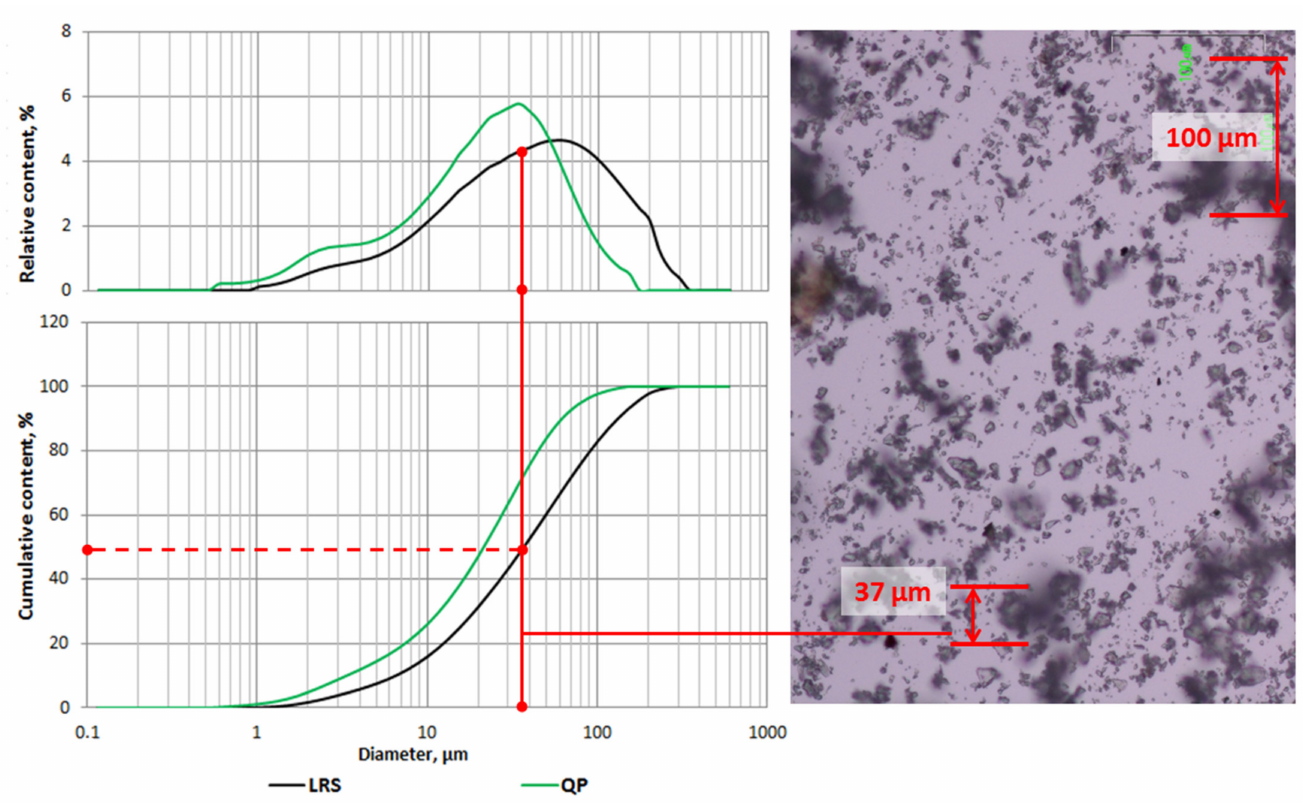
Figure 4. Particle size distribution plots of lunar regolith simulant (LRS) and quartz powder (QP) and micrograph of sharp-edged particles of LRS (magnification: 200 ×